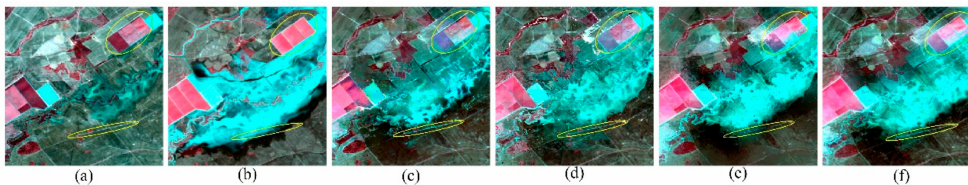
Figure 8. Zoomed in scenes of the black square areas marked in Figure 7. From left to right, ( a ) true Landsat image of 26 November 2004 (base date); ( b ) true Landsat image of 12 December 2004 (prediction date); ( c – f ) predicted images of 12 December 2004 by STARFM, STRUM, FSDAF, and EFSDAF, respectively.